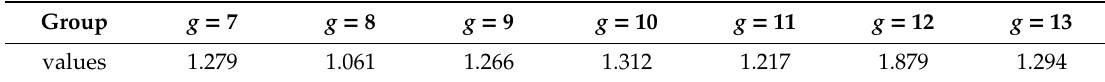
(cid:18) (cid:19) N 6,2 , σ g Table 21. Elements of S ( 2 ) , g = 1, ... ,30 with absolute values greater than 1.0. f ,1 Group g = 7 g = 8 g = 9 g = 10 g = 11 g = 12 g = 13 values 1.279 1.061 1.266 1.312 1.217 1.879